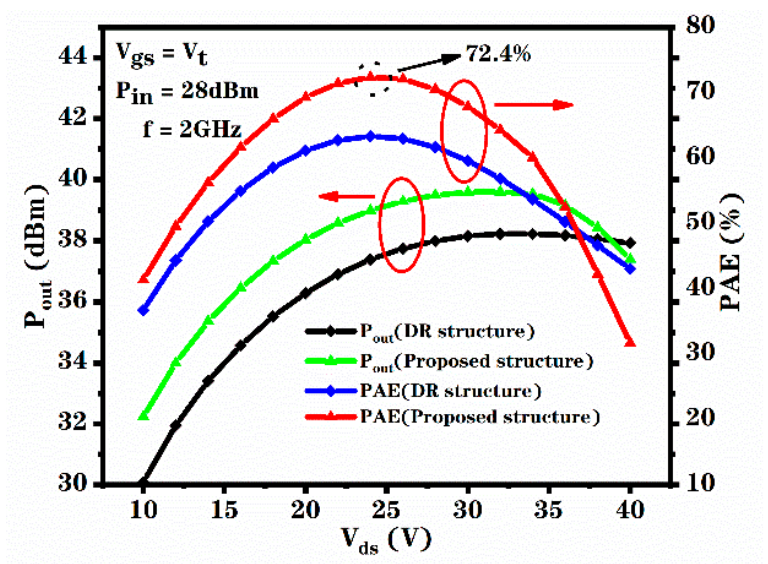
Figure 9. Relationship between PAE and V ds for the DR structure and proposed structure.